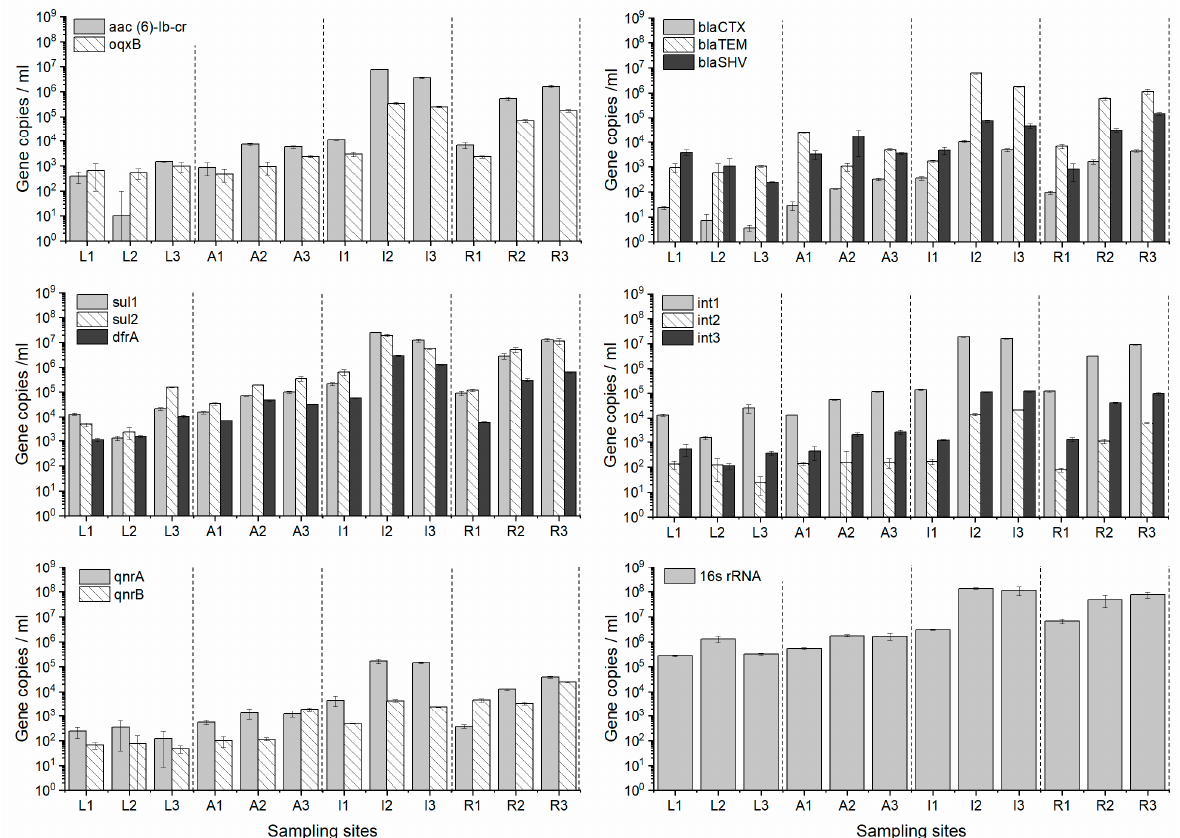
Figure 2. Concentration (copies/mL) of the ARGs, integrons, and the 16S rRNA gene in the surface water of the 12 sampling sites along the Saigon River impacted by different anthropogenic activities.